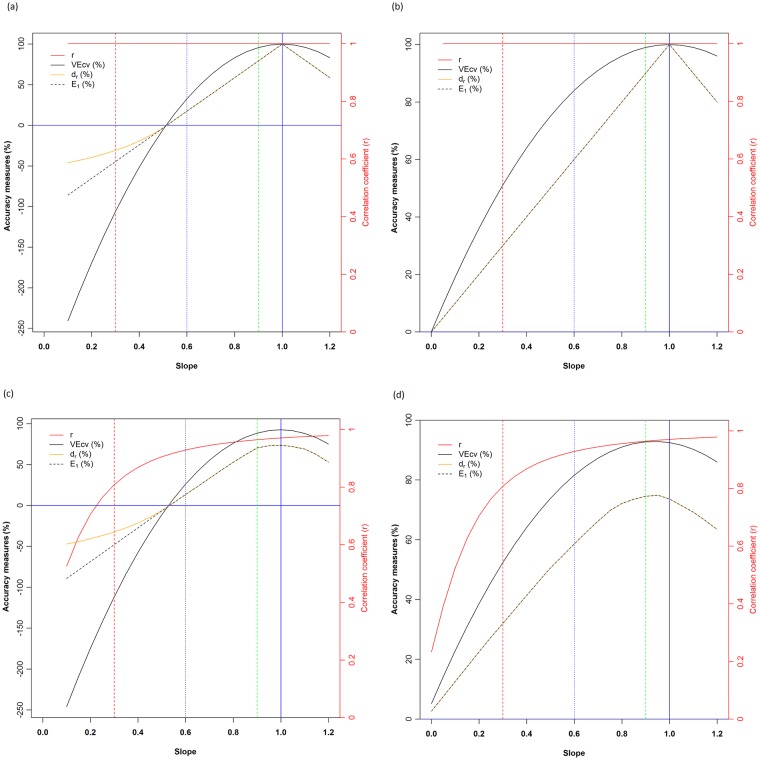
The changes of accuracy measures (VEcv, dr and E1) and r with slope for the four simulated scenarios: a) scenario 1; b) scenario 2; c) scenario 3; and d) scenario 4.For each scenario, a slope of 1 (blue vertical line), 0.9 (green dashed vertical line), 0.6 (blue dashed vertical line) and 0.3 (red dashed vertical line), and VEcv = 0 (blue solid horizontal line) were highlighted.